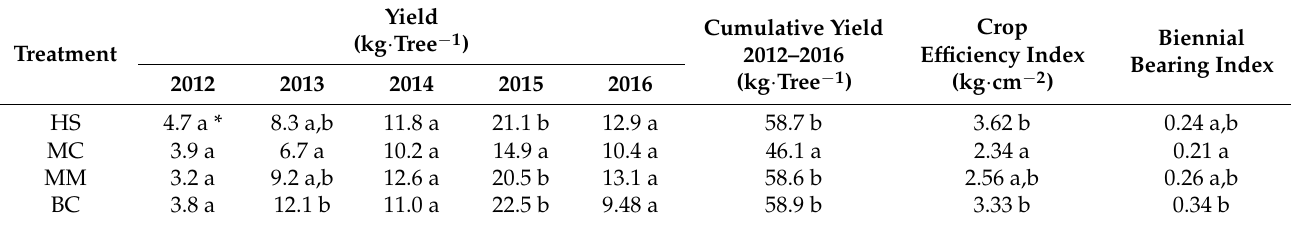
Table 1. Yield, crop efficiency, and biennial bearing index of apple trees cv. Gold Chief during 2012–2016, depending on the soil management